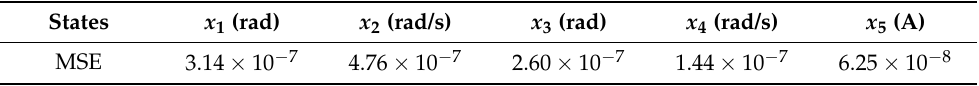
Table 2. The MSE of the ReLU-RNN predictive